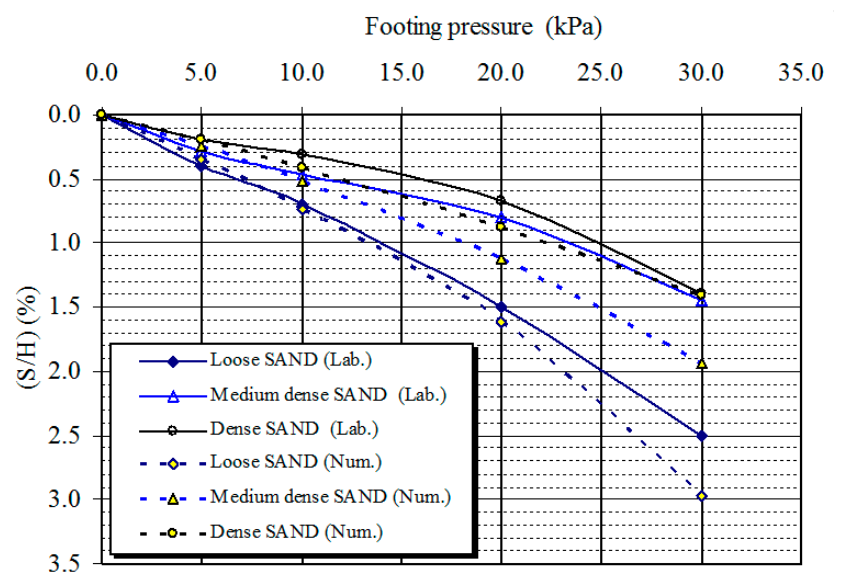
Figure 34. Footing settlement from laboratory and numerical models of nailed soil slope.